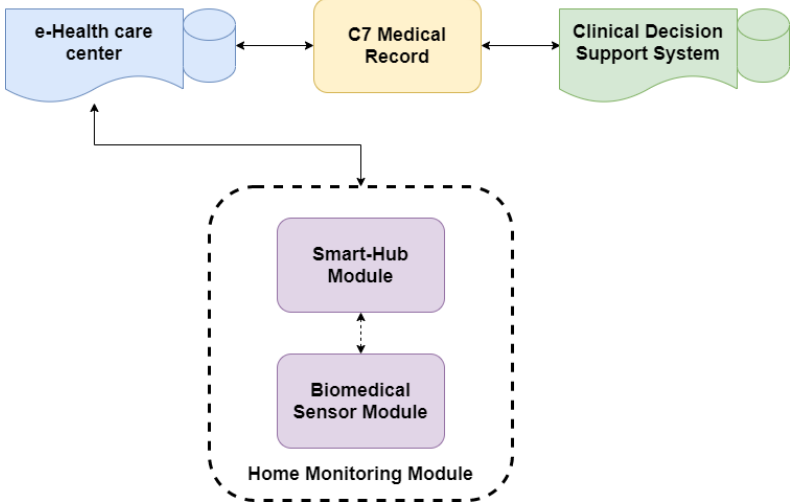
Figure 1. Architecture of the AIR CARDIO